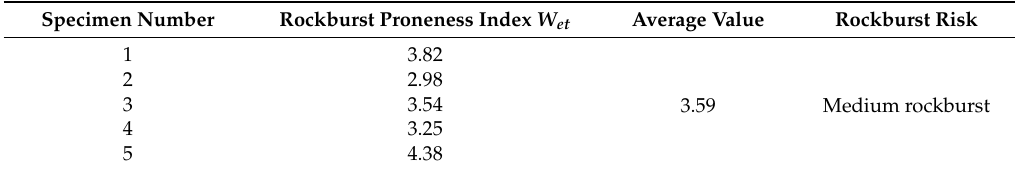
Table 2. Calculated results of rockburst proneness index.